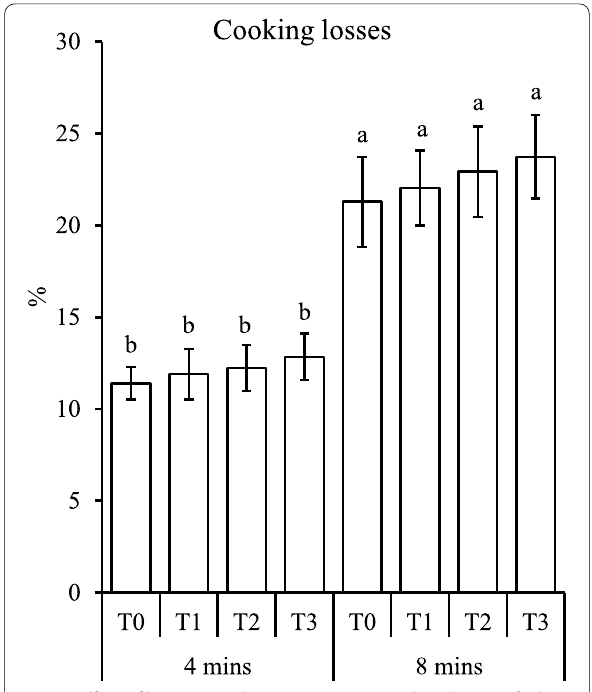
Fig. 2 Effect of banana peel incorporation in cooking losses of wheat flour noodles. Values are means ranked on HSD Tukey test ( p n 3, different letters on bars show the significant difference < 0.05. = Error bar represents the standard deviation. T 0 T 1 5% BPP 95% =